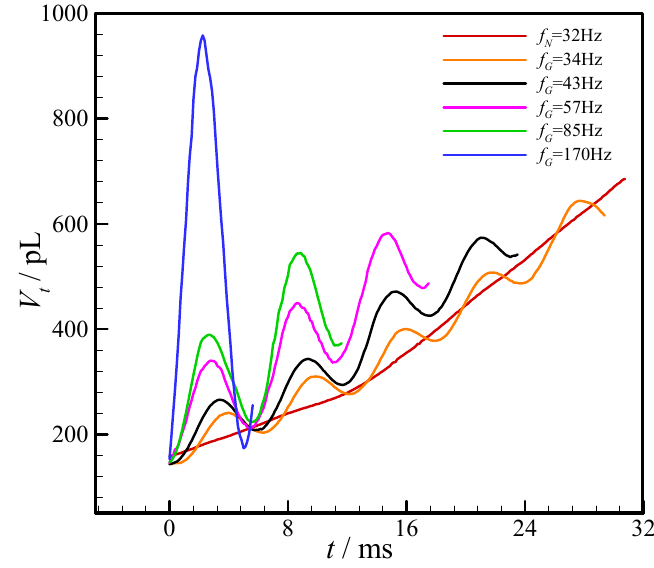
Figure 11. Evolutions of dispersed thread head volume with time during droplet generation process with external mechanical vibration. ( Q c = 60 μ L/h, Q d = 60 μ L/h, f P = 170 Hz, and a m = 0–136.3 m/s 2 .).